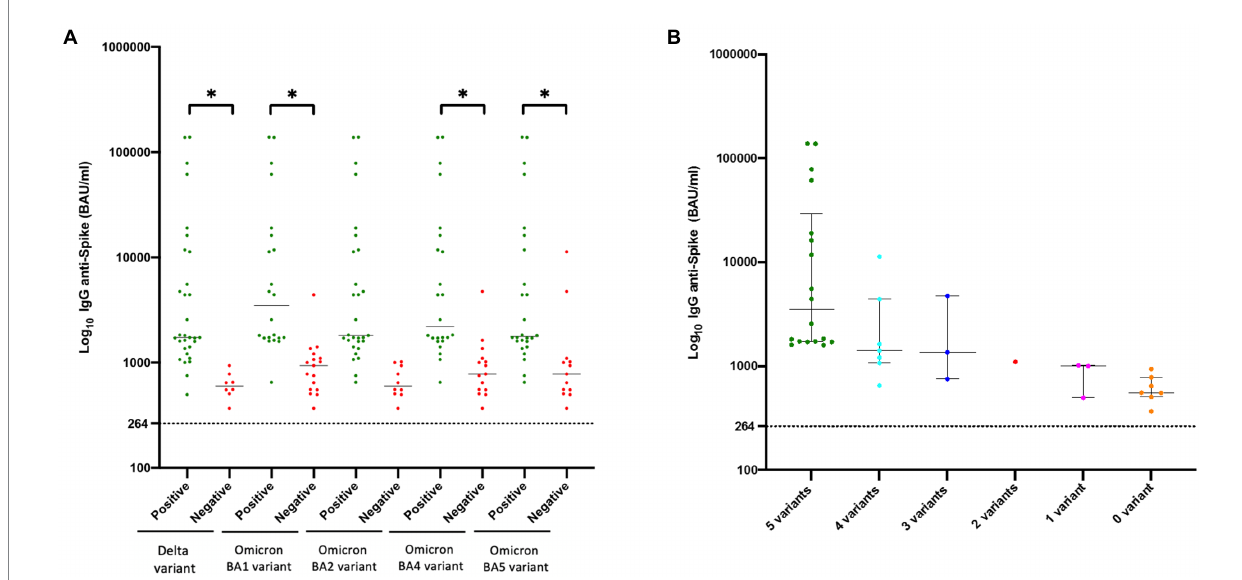
FIGURE 3 Anti-SARS-CoV-2 humoral immunity in 39 kidney transplant recipients according to anti-spike antibody concentrations. Concentrations of anti-SARS- CoV-2 IgG are expressed in Log10BAU/mL. The black bar represents the median value (A) . Concentrations of anti-SARS-CoV-2 IgG were compared between sera with and without neutralizing activity for each virus using one-way ANOVA followed by Tukey’s multiple comparison test; * p < 0.05. Each point represents one serum sample. The point is green if the serum presented neutralizing activity and red if not. (B) Concentrations of anti-SARS- CoV-2 IgG were compared between sera neutralizing different numbers of variants.